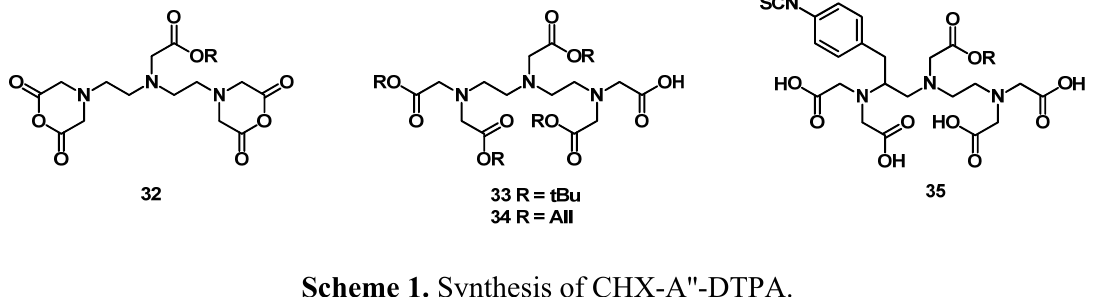
Scheme 1. Synthesis of